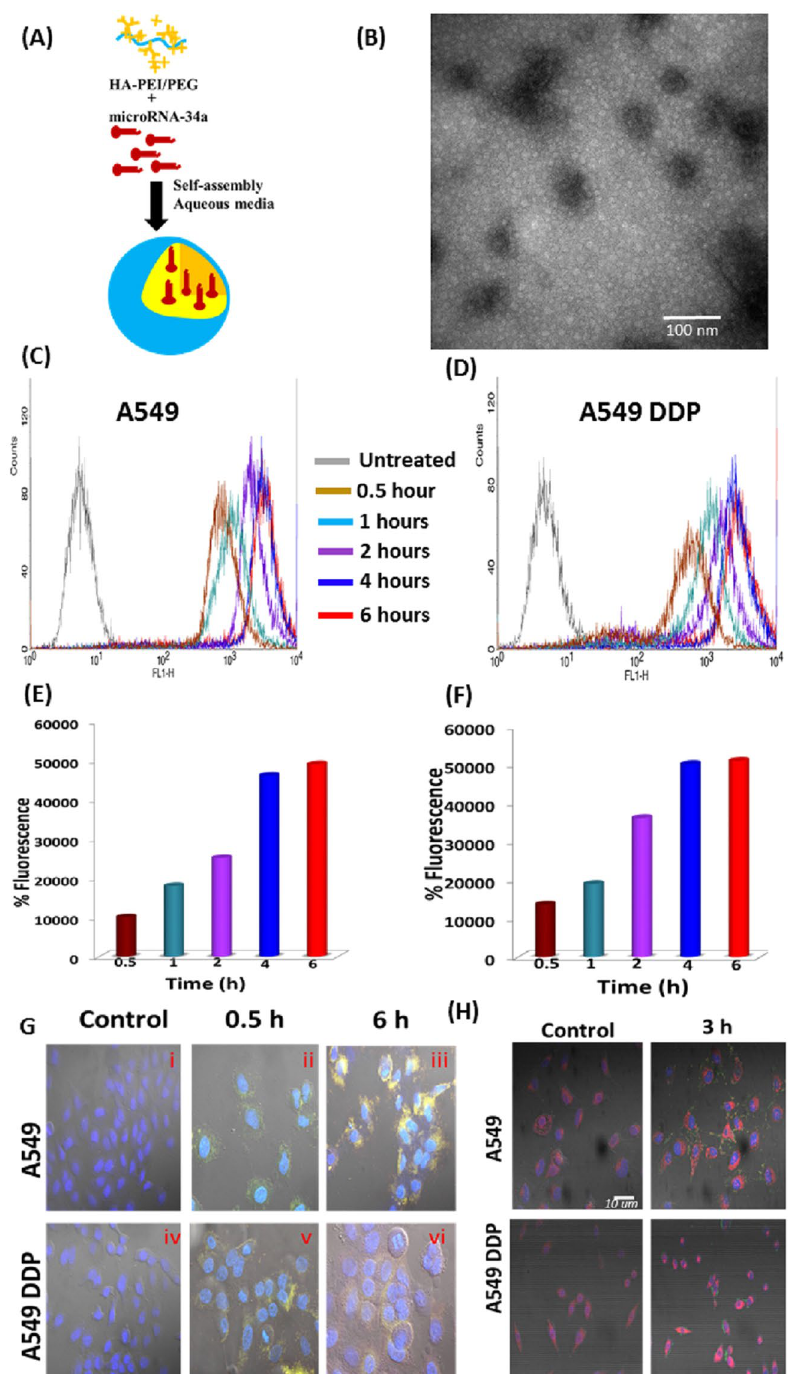
Figure 1. Characteristics of miR34a hyaluronic acid (HA)-based nanoparticles. ( A ) Schematic representation of HA-PEI/HA-PEG nano-assemblies encapsulated with miR34a duplexes. (B) The self-assembling miR34a HA-NPs nanoparticles showed a spherical morphology in TEM. (C–F) Flow cytometry analysis indicated that the miR34a HA-NPs were taken up by the A549 cells and cisplatin resistant A549 cells (A549 DDP) cells in a time dependent manner. The HA-PEI was conjugated with rhodamine dye and the miR34a was conjugated with FITC. (G , H) Confocal images to support the flow cytometry results indicating the uptake of the FITC-miR34a encapsulated in HAPEI nanovectors; mitochondria stained by MitoTrackr ™